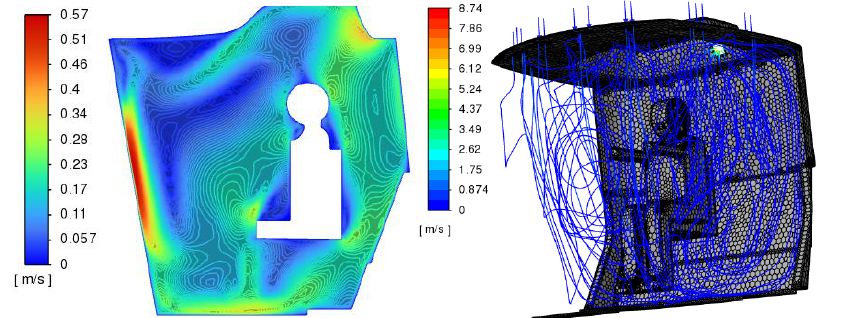
Figure 9. Velocity field m/s.